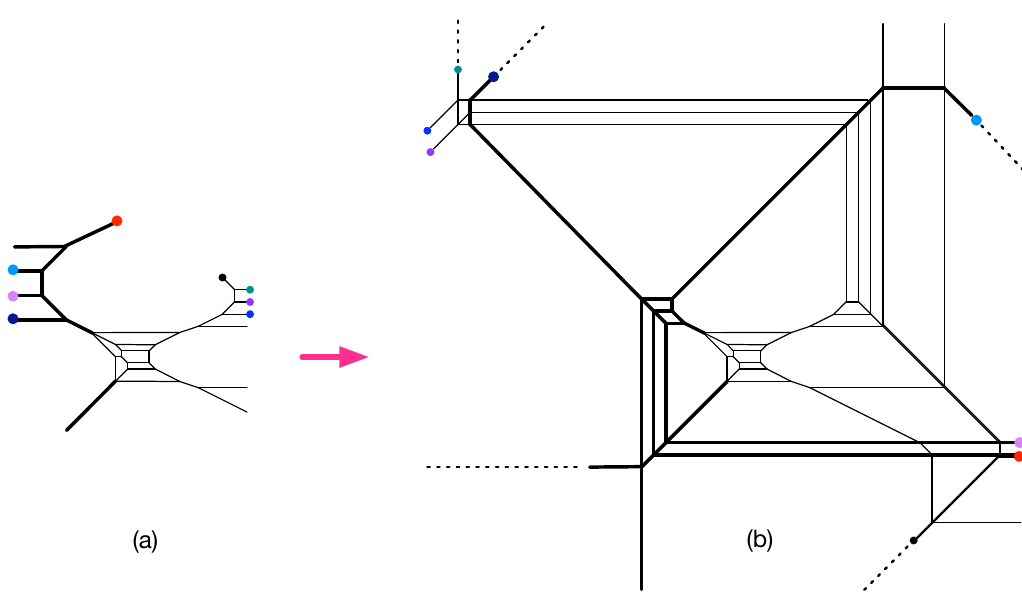
Figure 20 . SU(6) 3 + 1